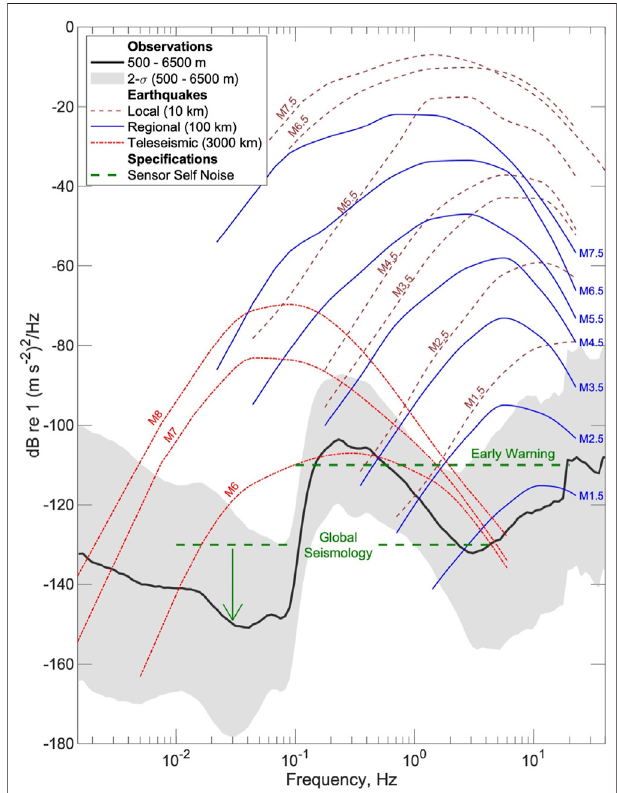
FIGURE 8 | Vertical acceleration spectra showing sea fl oor noise levels, typical earthquakes of various magnitudes at local (10 km), regional (100 km) andteleseismic(3,000 km)distances,andillustrativeaccelerometerself-noise speci fi cations for earthquake and tsunami early warning and global seismology. The arrow illustrates the potential bene fi t for global seismology applications of sensors with very low self-noise at lower frequencies. Sea fl oor noise levels are from a compilation of over a decade of US ocean bottom seismometer experiments (Janiszewski et al., 2020) and show average noise levels and two standard deviation variations at depths greater than 500 m. The acceleration spectra of typical earthquakes are from Clinton and Heaton (2002) and have been converted from octave wide bandpass acceleration to power spectral density following Cauzzi and Clinton (2013).